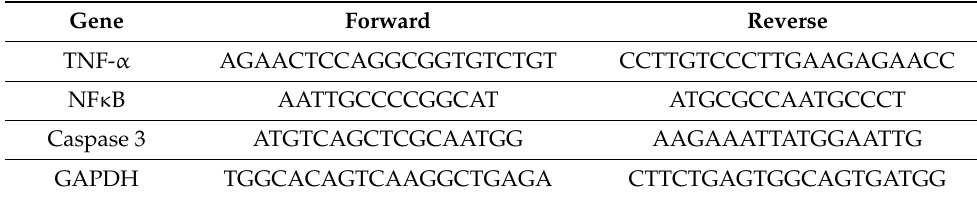
Table 1. Primer sequences of genes measured in the